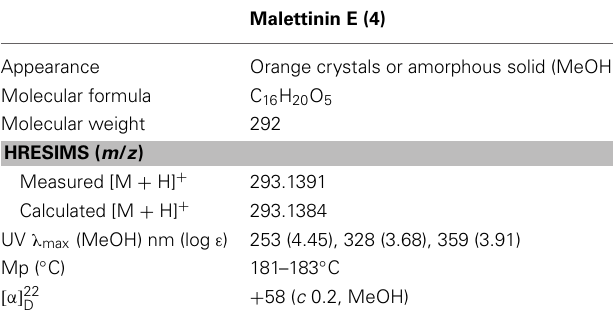
Table 2 | Physico-chemical properties of malettinin E